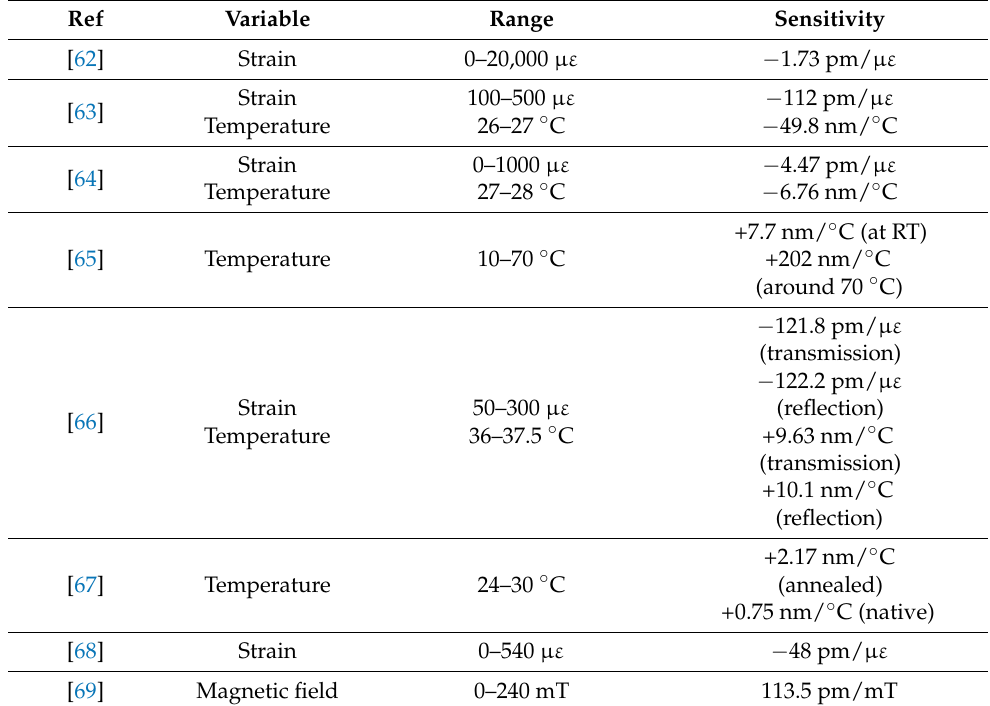
Table 4. Summary of the relevant parameters of MMI sensors based on plastic optical